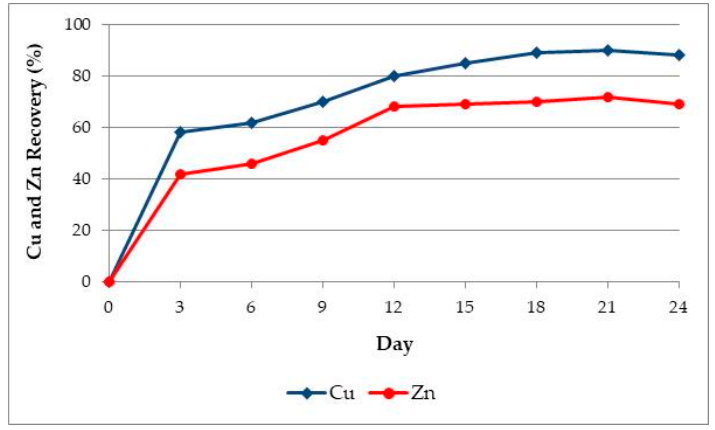
Figure 5. Copper and Zinc recovery vs. time with pulp density of 10% ( w / v ); 30 °C; pH 2 on the start of process; Nutrient medium solution 9K; Air 0.5 NL/min and CO 2 = 20 mL/min.